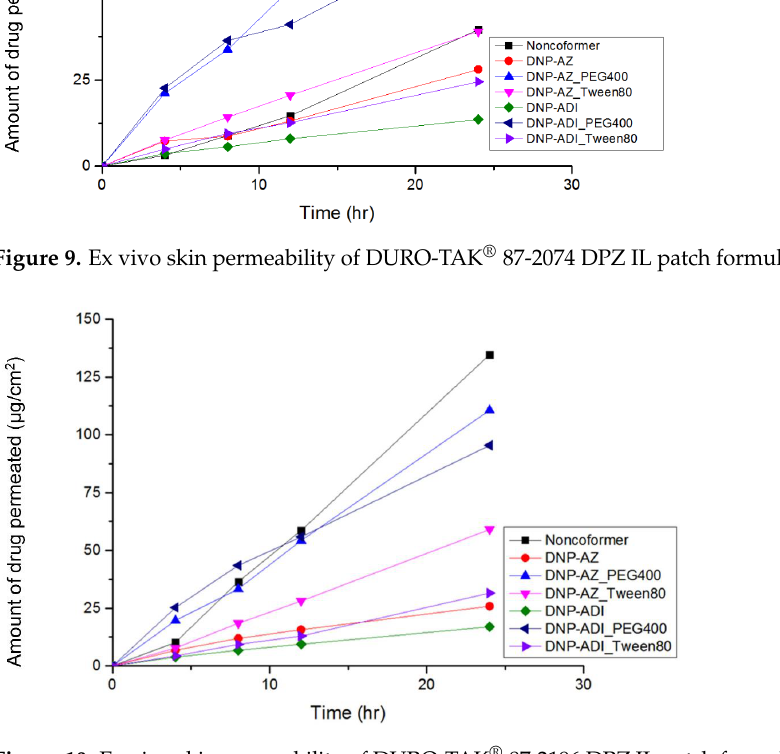
Figure 10. Ex vivo skin permeability of DURO-TAK ® 87-2196 DPZ IL patch formulation. (mean, n = 3).